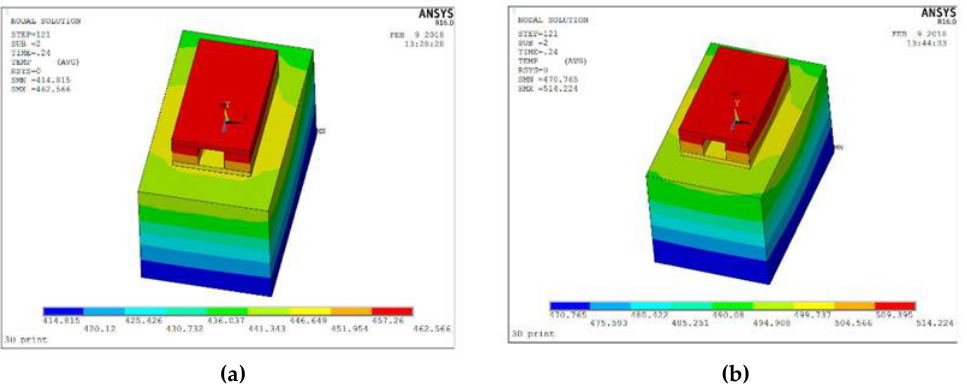
Figure 7. Distribution of the temperature field after scanning. The object on the left uses the scanning strategy printing along the feature ( a ) while the object on the right uses the scanning strategy-printing vertical to the feature ( b ).